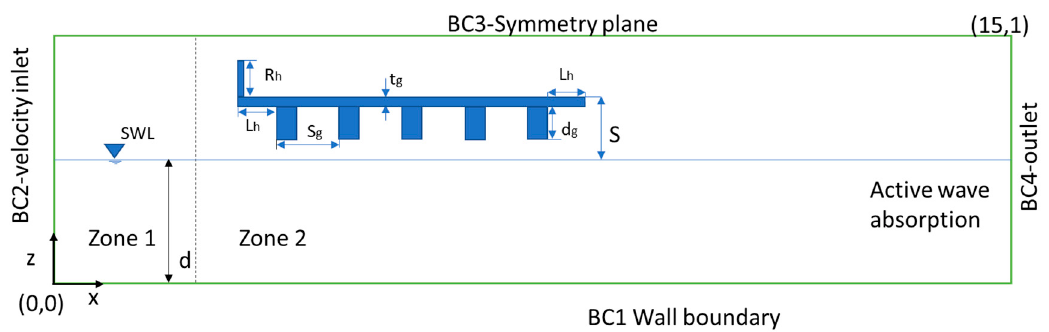
Figure 4. Numerical wave tank with the boundary condition and the deck with girders and railings.